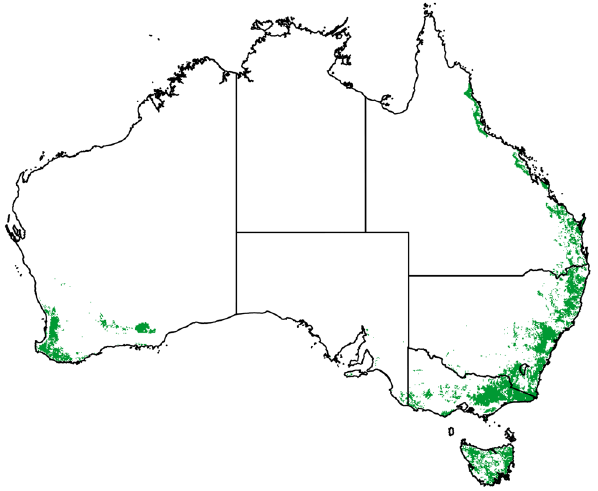
Fig. 9 Forest ecosystems distribution used in our study. The following vegetation types from the Australian National Forest Inventory are included (250 m spatial resolution): Eucalypt low closed, Eucalypt low open, Eucalypt low woodland, Eucalypt medium closed, Eucalypt medium open, Eucalypt medium woodland, Eucalypt tall closed, Eucalypt tall open, Eucalypt tall woodlands, Rainforest, Leptospermum, Banksia, Other native forest, Softwood plantation, Hardwood plantation, Mixed species plantation and Other forests (unallocated types). Nominal forest types occurring in savanna, rangeland, and littoral ecosystems are not included: Callitris, Casuarina, Eucalypt Mallee, Mangrove,